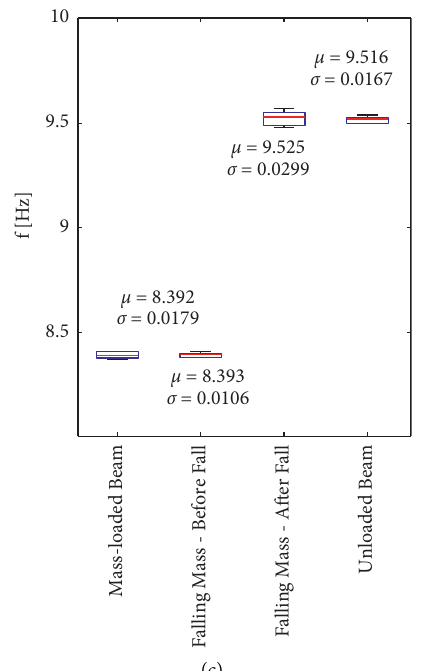
Figure 9: Results from the cantilevered beam (3rd experimental setup, mid-length virtual sensor). (a) An example of IF for the unloaded beam; (b) an example of IF for the mass-loaded beam; (c) boxplots of all acquisitions (5 mass-loaded, 5 unloaded, and 10 with falling mass) and the respective mean values and standard deviations. Please notice that the first seconds (corresponding to the initial impact) were removed from all signals.